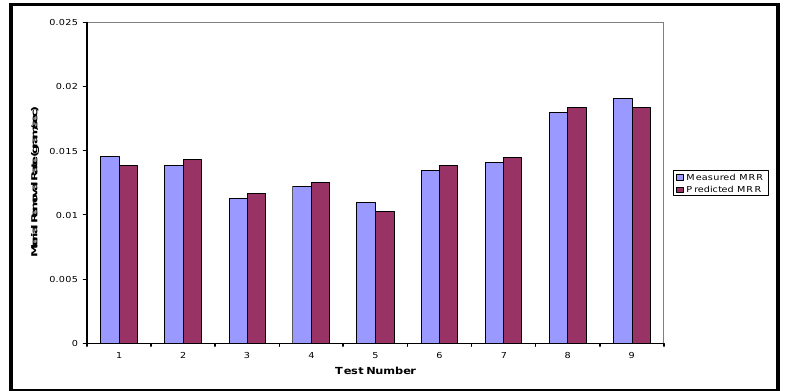
Fig. 6. The diagram of the measured and predicted material removal rate for the experimental